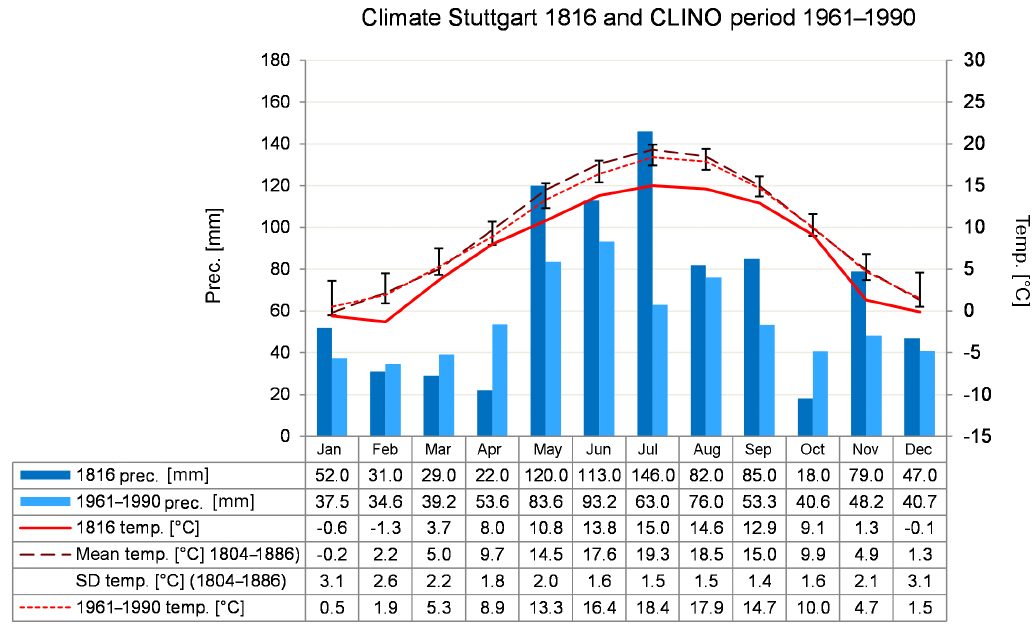
Figure 8. Temperature and precipitation for Stuttgart for the year without summer